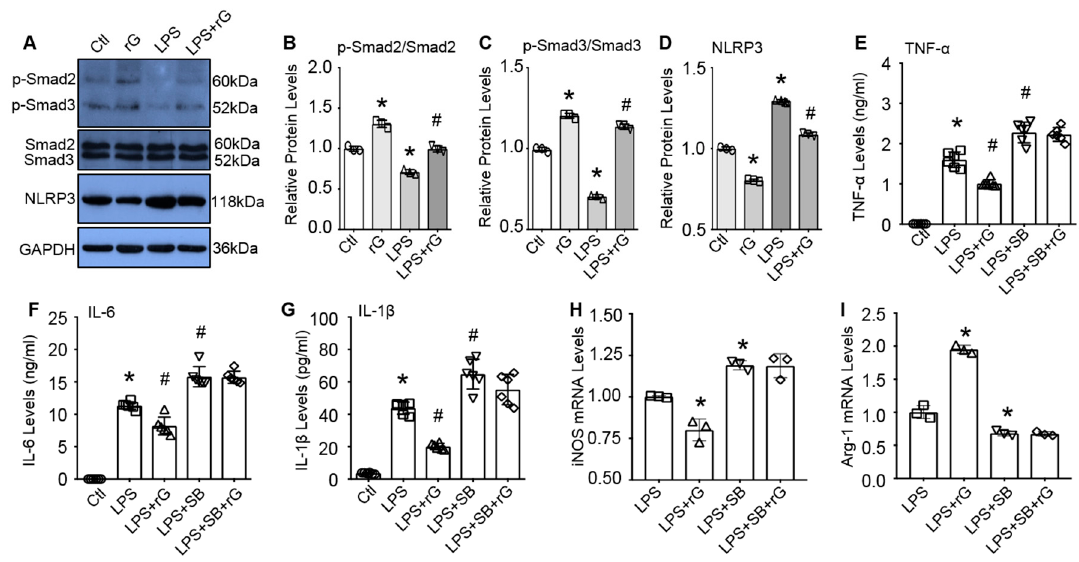
Figure 7. GDF3-mediated macrophage M2 phenotype is associated with the activation of Samd2 / 3 and inhibition of NLRP3 inflammasome. ( A ) Representative immuno-blots and quantification results for ( B ) p-Samd2, ( C ) p-Smad3 and ( D ) NLRP3. GAPDH was used as a loading control for total protein (*, p < 0.05 vs. Ctl cells, #, p < 0.05 vs. LPS treated cells; n = 3). ( E – G ) RAW264.7 macrophages were pre-treated with SB431542 or DMSO (10 µ M) for 0.5 h, then incubated with rGDF3 (50 ng / mL) or BSA for 1 h, followed by stimulation with LPS (10 ng / mL) for 12 h. Supernatants were collected to measure ( E ) TNF- α , ( F ) IL-6, and ( G ) IL-1 β levels (*, p < 0.05 vs. Ctl cells; #, p < 0.05 vs. LPS-treated cells; n = 4). The mRNA levels of ( H ) iNOS and ( I ) Arg-1 in these macrophages treated as above were measured